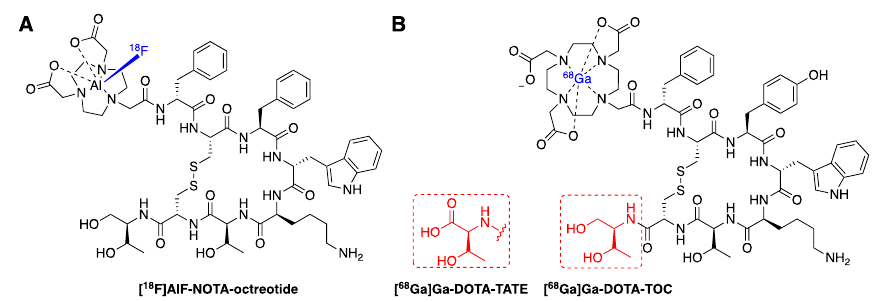
Fig. 4 Structure of A [ 18 F]AlF-NOTA-octreotide and B [ 68 Ga]Ga-DOTA-TATE/[ 68